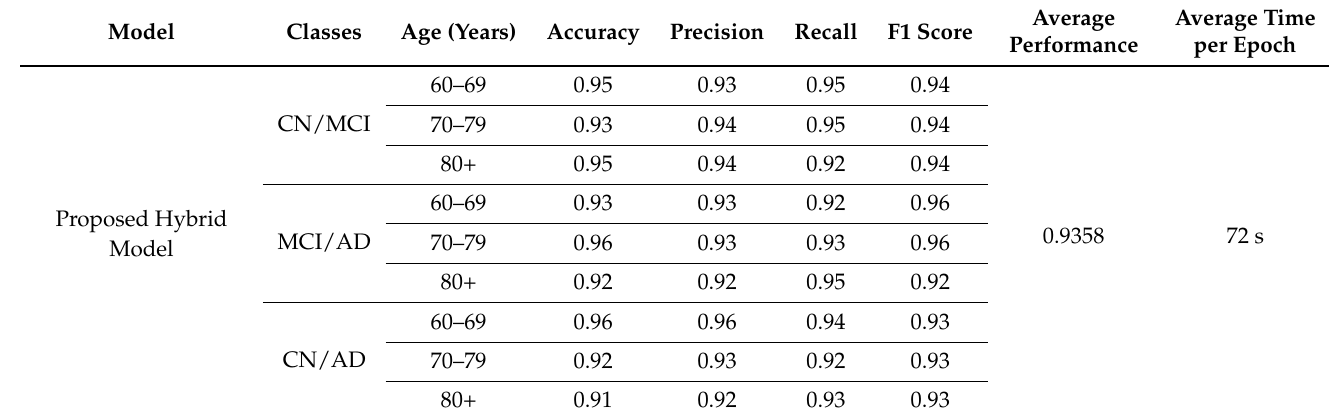
Table 4. Performance evaluation table of the proposed hybrid